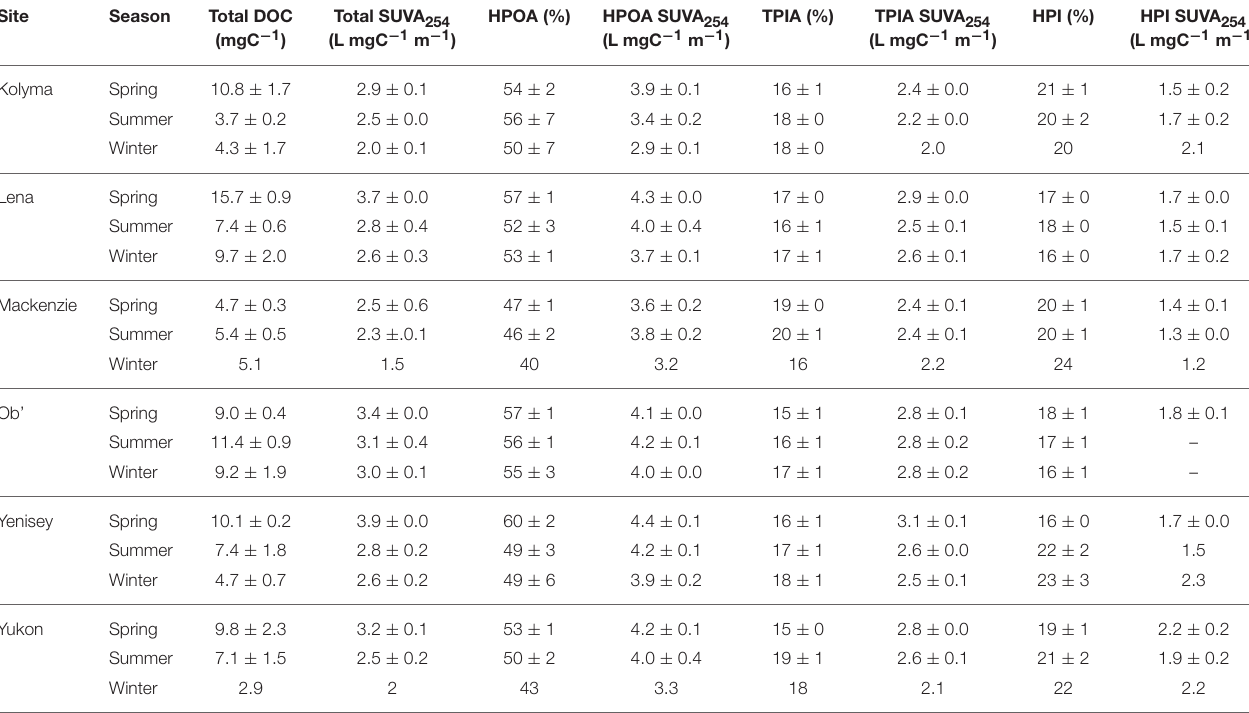
TABLE 1 | Total dissolved organic carbon concentrations (DOC) and major chemical fractions of DOC and fraction-specific ultraviolet absorbance (SUVA 254 ) across the six great Arctic rivers (mean ± standard error) during Spring (May and June), Summer (July through to October) and Winter (November through to